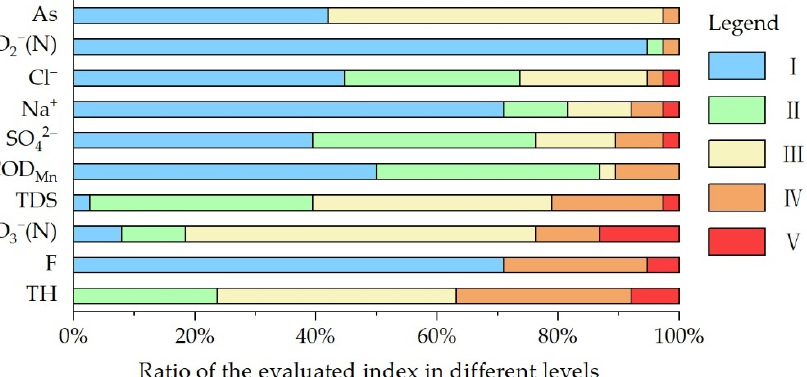
Figure 9. Evaluated results of groundwater, the division of the I~V levels was based on the Standard for Groundwater Quality (GB/T 14848-2017) [28].